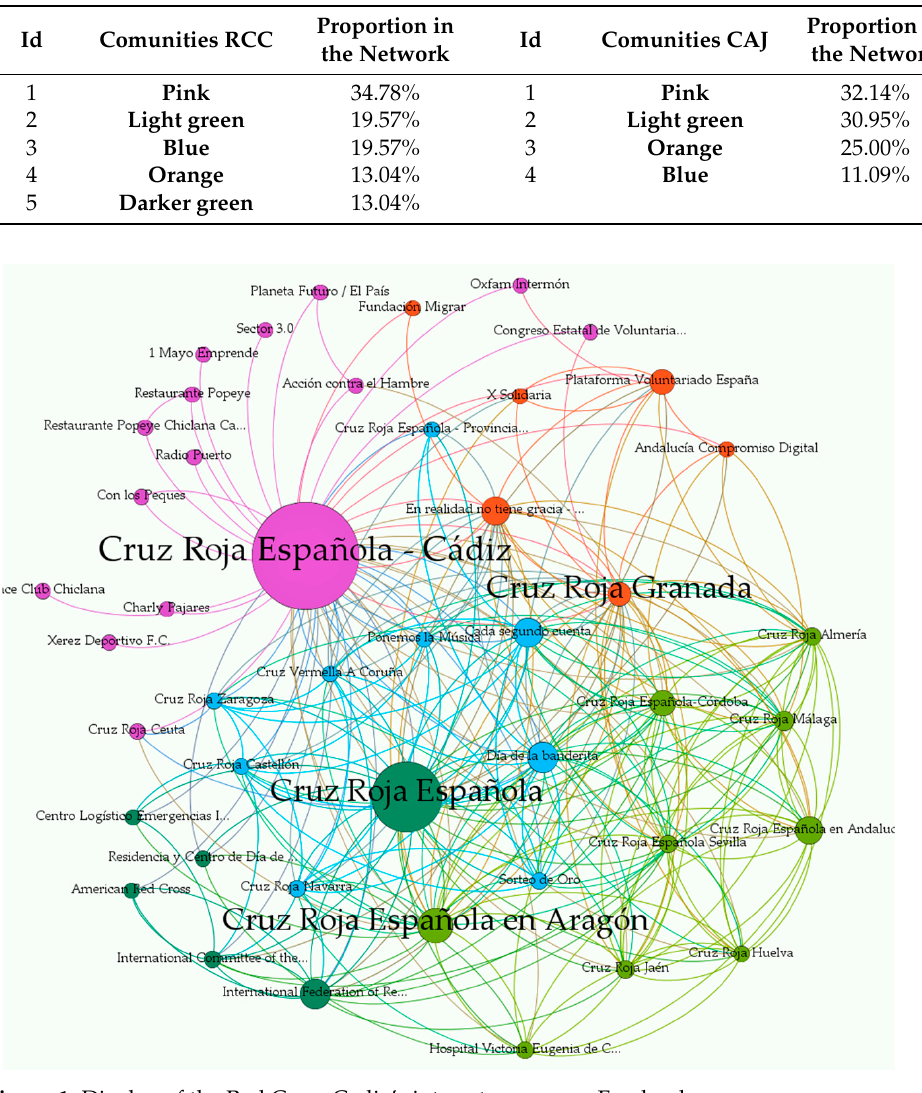
− Community One (pink), corresponding to the organizations in the surrounding area (catering companies in Chiclana, or media such as Radio Puerto in El Puerto de Santa Maria). − Community Two (light green) corresponding to Red Cross organizations in Andalusia (Red Cross Seville, Red Cross Huelva, Etc.), although, curiously, Red Cross Ceuta, which is very close to Cadiz, is not part of this community. − Community Three (blue), corresponding to Red Cross organizations on the national level or representative pages of solidarity campaigns such as “Gold Draw” and “Flag Day.” − Community Four (orange), corresponding to Red Cross Granada and pages of various kinds such as the Volunteer Platform or Andalusia Digital Commitment. − Community Five (darker green), consisting of three international organizations: The International Federation of Red Cross and Red Crescent Societies, the International Committee of the Red Cross, the American Red Cross; and three national organizations, the Spanish Red Cross, a San Fernando Day Center, and an emergency center.